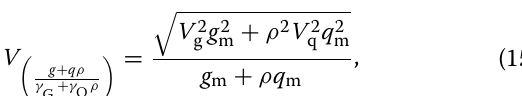
Fig. 3 Reliability results for combination of dead and office floor live